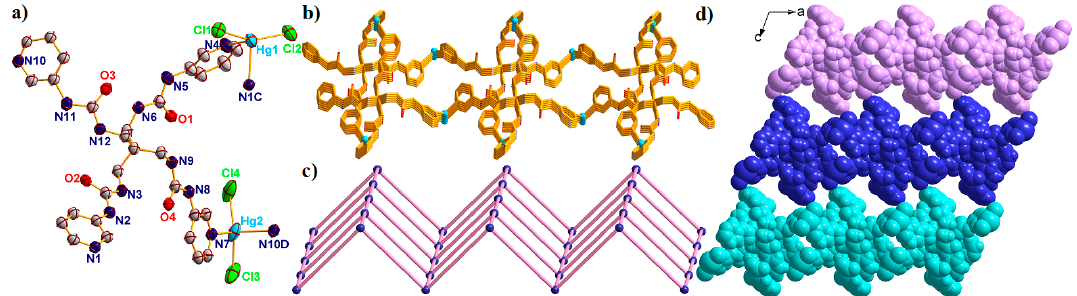
Figure 7. ( a ) The asymmetric unit of complex 6 with 50% probability ellipsoids. (Symmetry codes: C: 2 − x , − 1/2 + y , 1 − z ; D: − 1 + x , y , z ). The 2D [Hg 2 L] n sheet. ( c ) The 2D 4-connected {4 4 ·6 2 }- sql sheet of 6 . ( d ) Space filling 3D supramolecular structure of 6 viewed along the b direction. All solvents have been omitted for clarity.